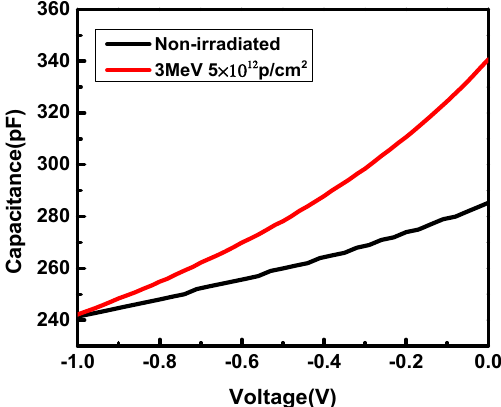
Figure 2. Capacitance–voltage curves.